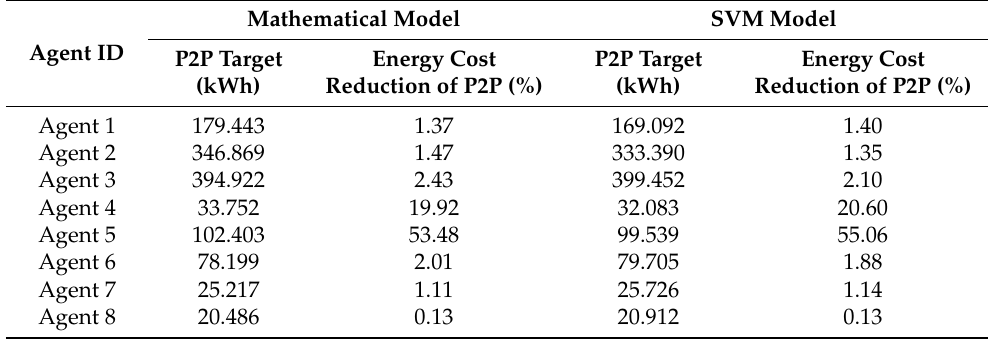
Table 1. Energy community results considering the mathematical and the SVM models.